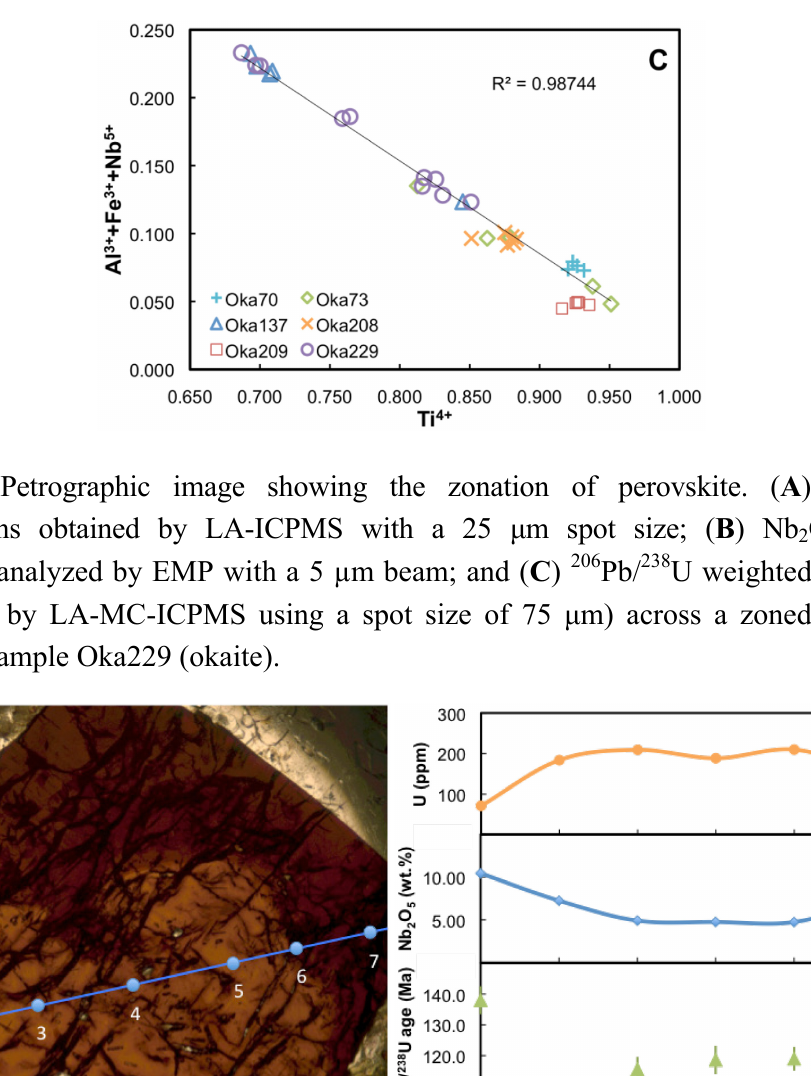
Figure 6. Chondrite normalized Rare Earth Element (REE) patterns for perovskite from alkaline silicate samples at Oka. Chondrite values are from McDonough and Sun [55].